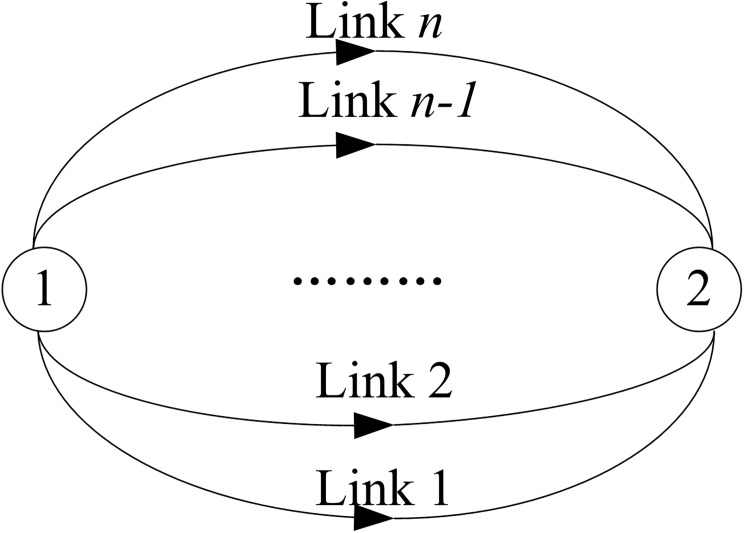
Validation network.